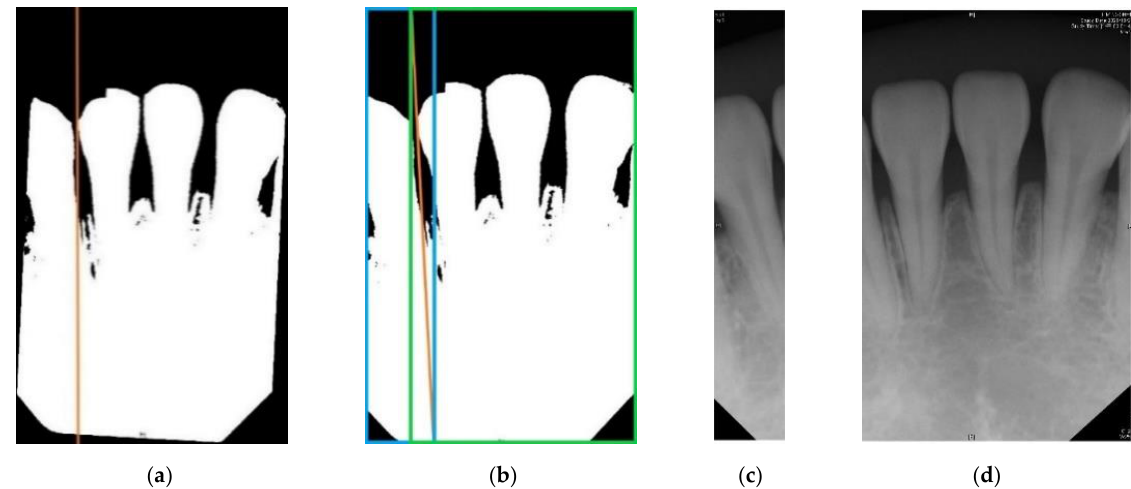
Figure 4. ( a ) Schematic diagram of the cutting line found by vertical projection; ( b ) schematic diagram of the cutting range; ( c ) and ( d ) are the output photos after vertical cutting the photo in ( b ).